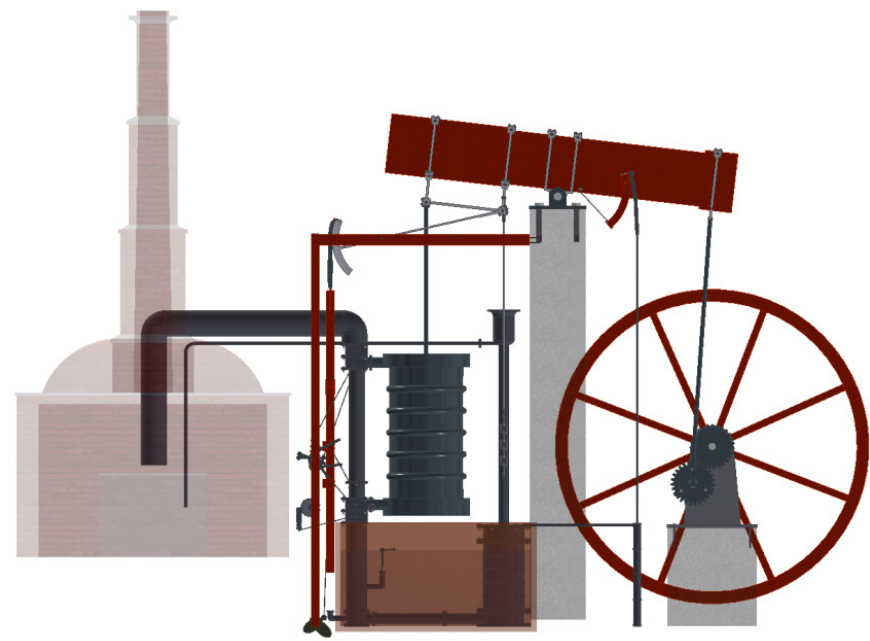
Figure 4. Simplified model of the double-acting steam engine for static analysis.